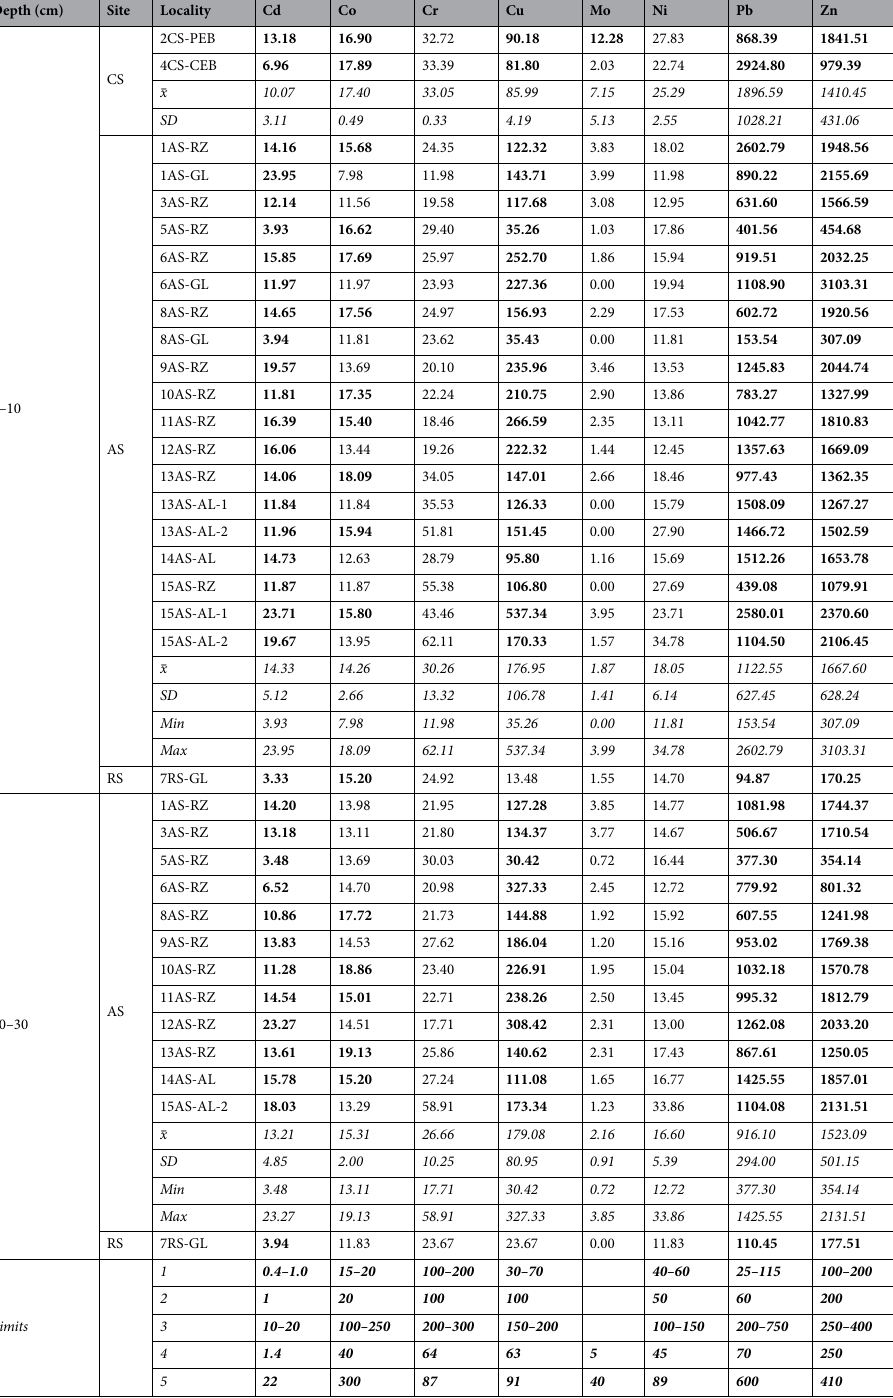
Table 3. Total content (T) of heavy metals in the soil depth of 0–10 and 20–30 cm in contaminated, alluvial and reference sites with basic statistical characteristics compared to threshold and guideline values (mg/kg). AS alluvial site, CS contaminated site, RS reference site (used to determine background values), RZ riparian zone, AL arable land, GL grassland, PEB probable environmental burden, CEB confirmed environmental burden. Signs mean: 1—Slovak threshold value of soil contamination in agricultural soil, 2—Finish threshold value of soil contamination, 3—Finish guideline values of soil contamination and remediation needs, 4—Canadian soil quality guidelines for the protection of environmental and human health for agricultural land, 5—Canadian soil quality guidelines for the protection of environmental and human health for industrial land. Normal letter means below all threshold values; bold letter means above at least one threshold